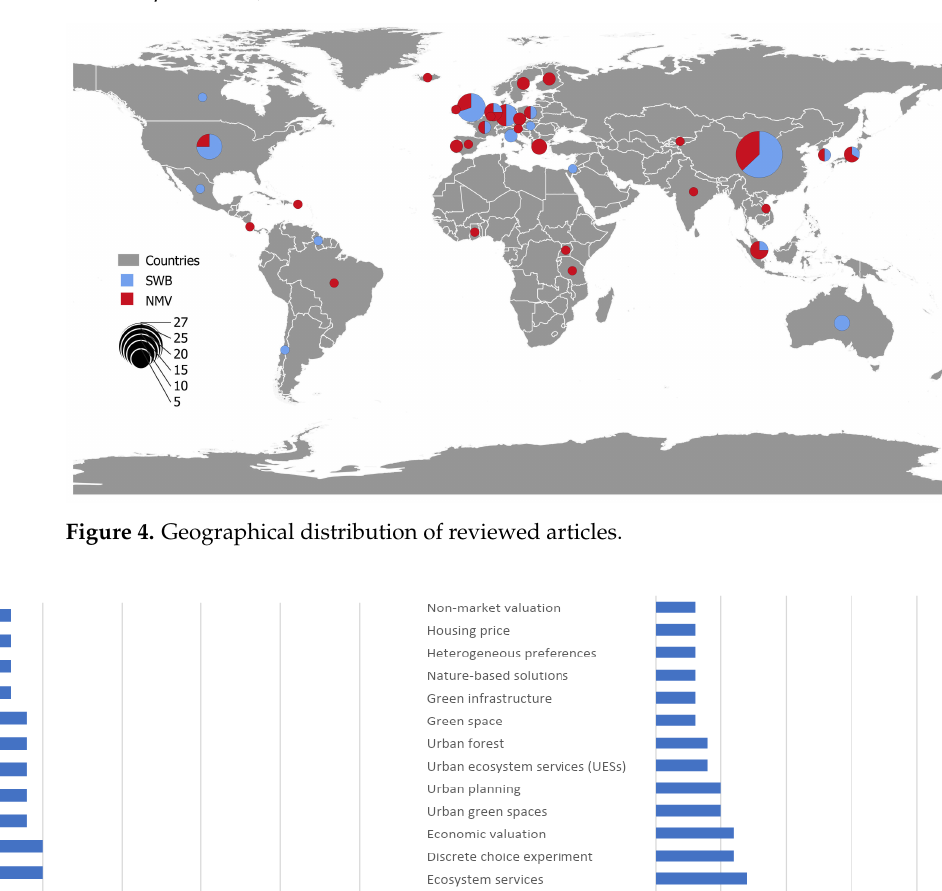
Figure 4. Geographical distribution of reviewed articles.